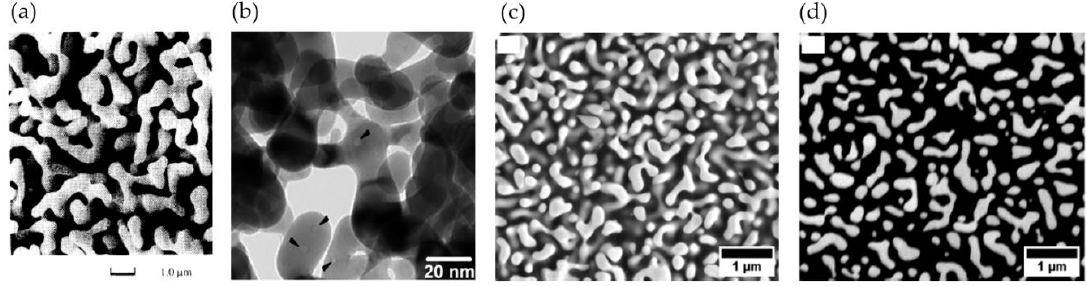
Figure 2. Nanoporous gold imaged using ( a ) 2D SEM by Li and Sieradzki [25]; ( b ) TEM by Rösner et al. [16]; ( c ) SEM image of a focused ion beam (FIB) milled cross section of epoxy infiltrated nanoporous gold showing shine-through effect of underlying structure by Hu [36] and ( d ) effect eliminated by choosing different electron beam voltage [36]. Reprinted with permission from [25] Copyright (2020) by the American Physical Society; [16] with permission from John Wiley and Sons; [36] with permission from Kaixiong Hu.